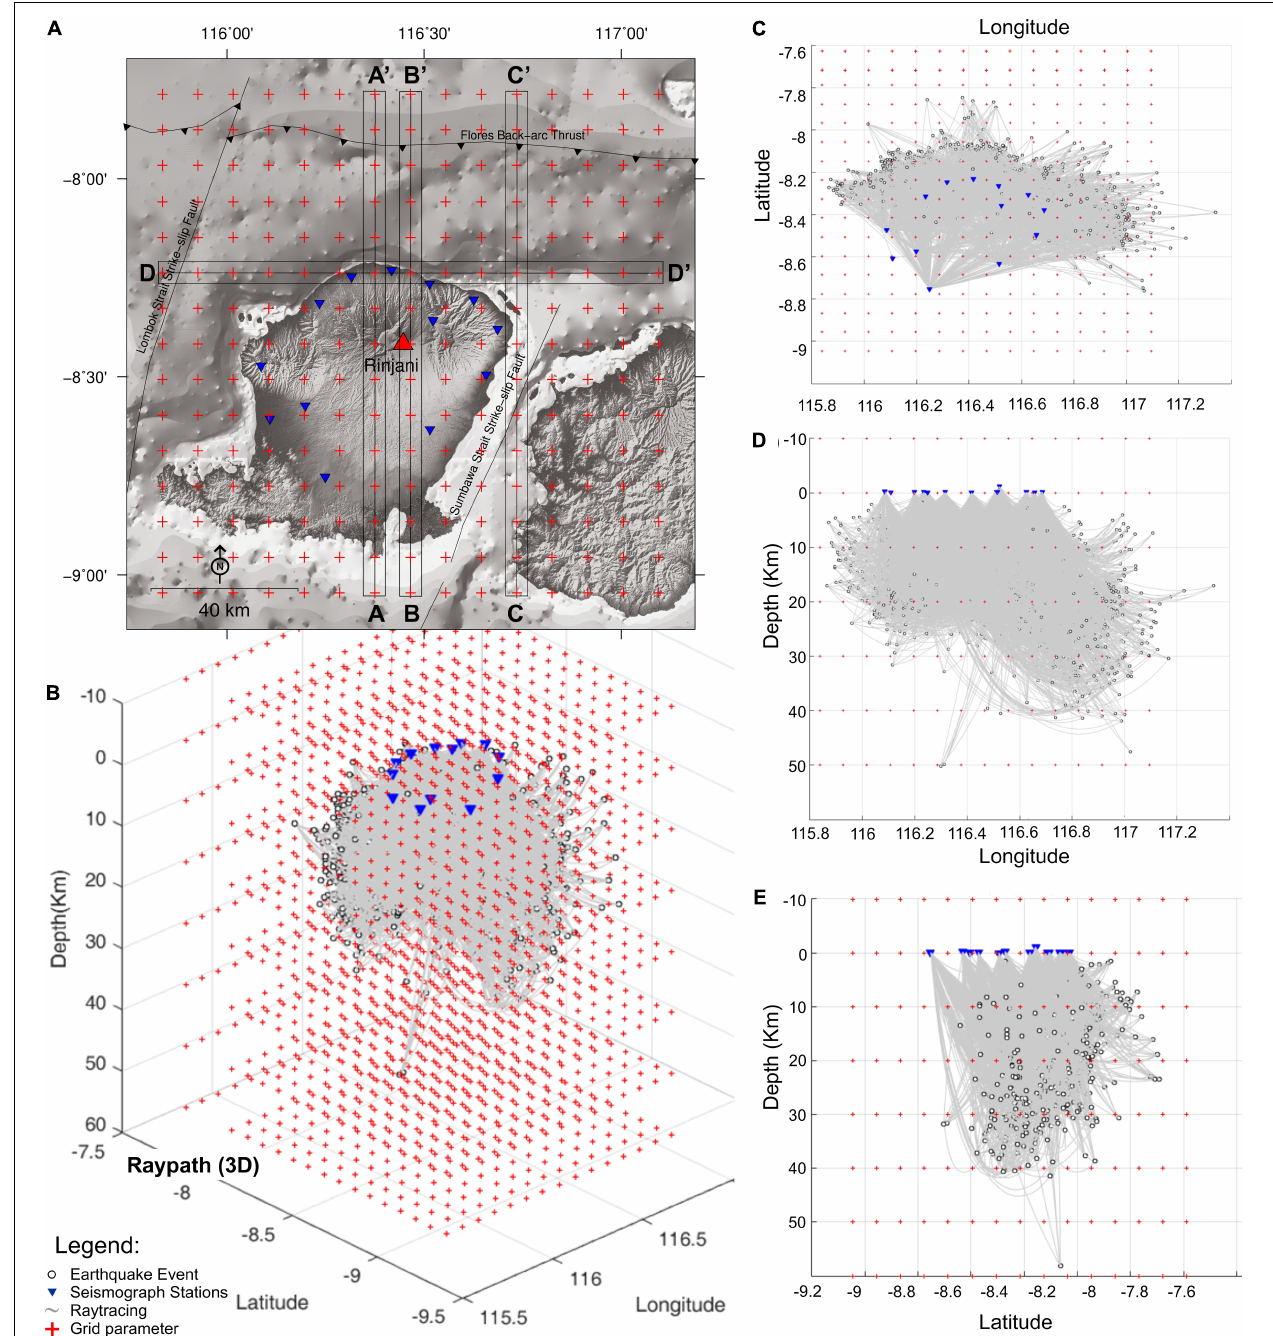
FIGURE 3 | (A) The vertical cross-section positions (AA (cid:48) , BB (cid:48) , CC (cid:48) , and DD (cid:48) lines) relative to grid node; the earthquakes plotted in the cross-sections are located within the areas indicated by the black rectangles (6 km in width); (B) the ray paths on 3D grid node; (C) the map view of ray paths; (D) the east-west cross-section of ray paths; (E) the northeast cross-section of ray paths. The inverted blue triangles indicate the stations; the gray lines indicate the ray paths; the open circles indicate hypocenters; the red plus marks indicate the grid nodes, the red triangle is the active volcano of Rinjani, the black lines are active faults, and the jagged black line is the FBT based on Irsyam et al. (2017).